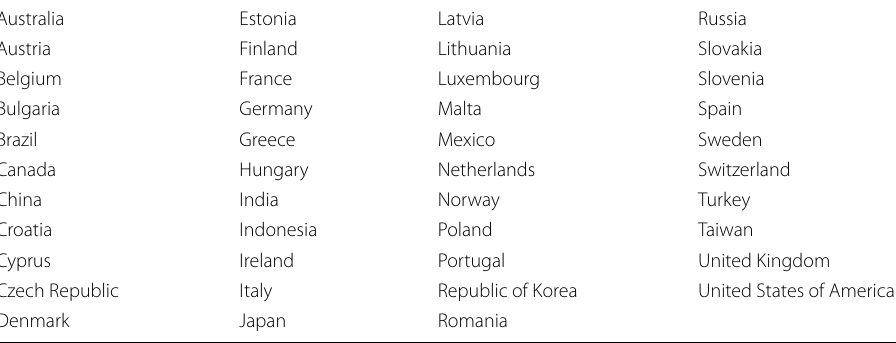
Table 4 The list of countries in WIOD